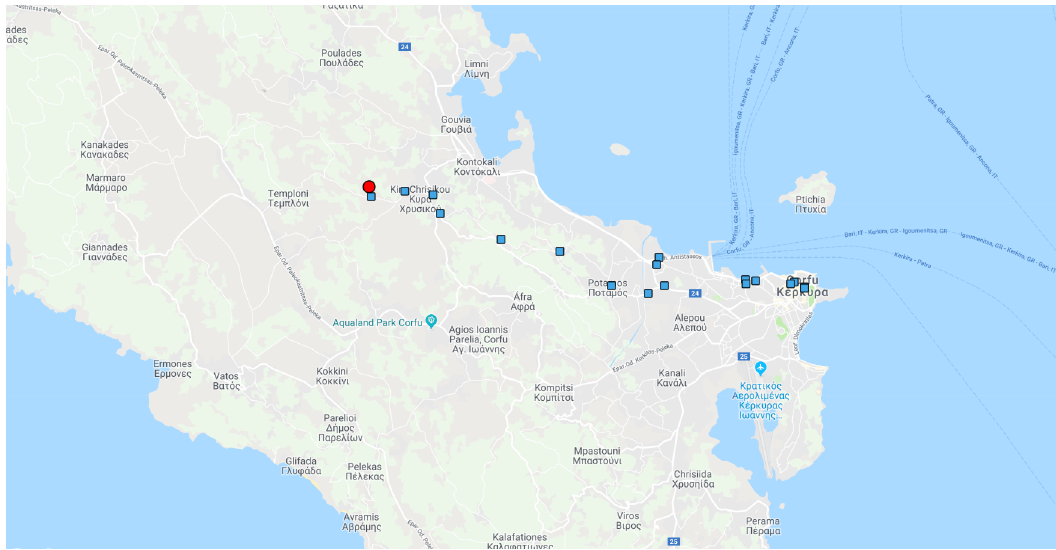
Figure 5. The case study of the recycling garbage trucks of